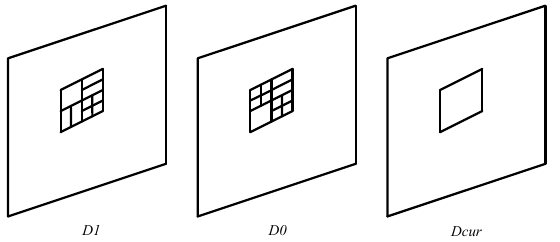
Figure 3. An example of current coding frame and adjacent coded